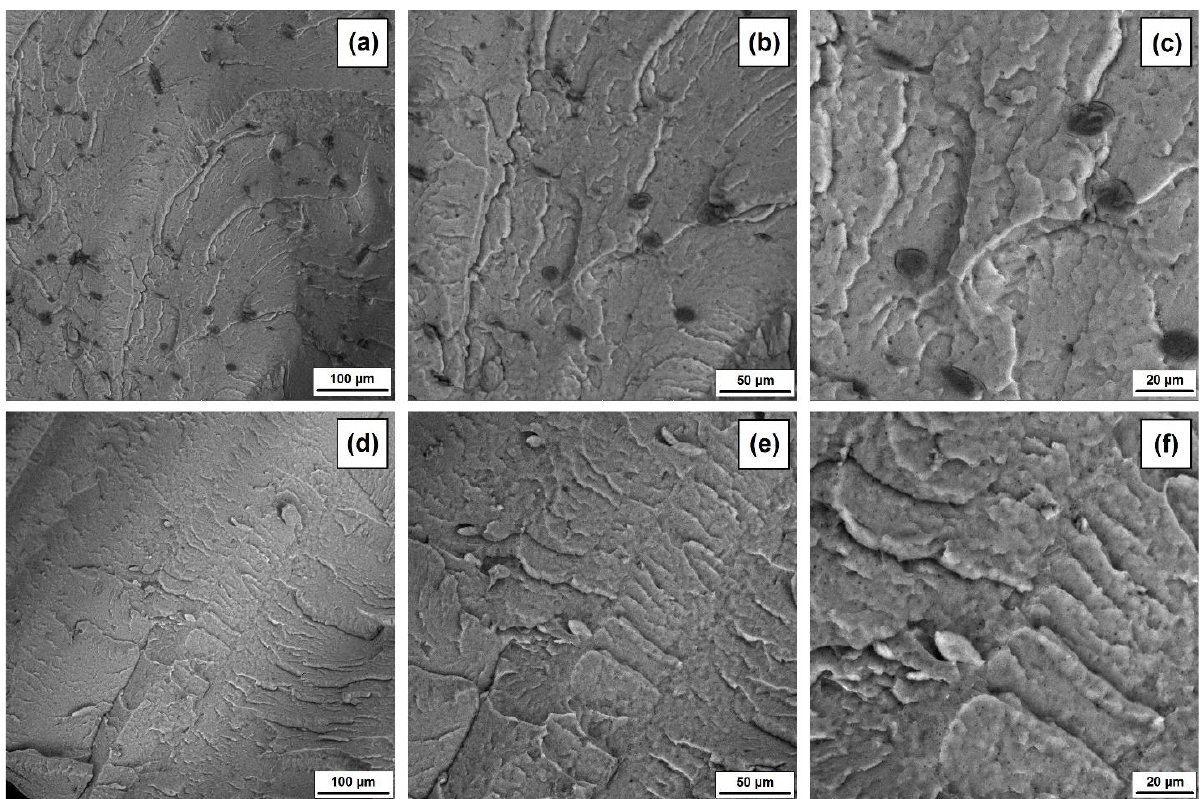
Figure 11. SEM images for PVC with 5 wt% of lignin ( a – c ) and halloysite ( d – f ) at different magnifi-